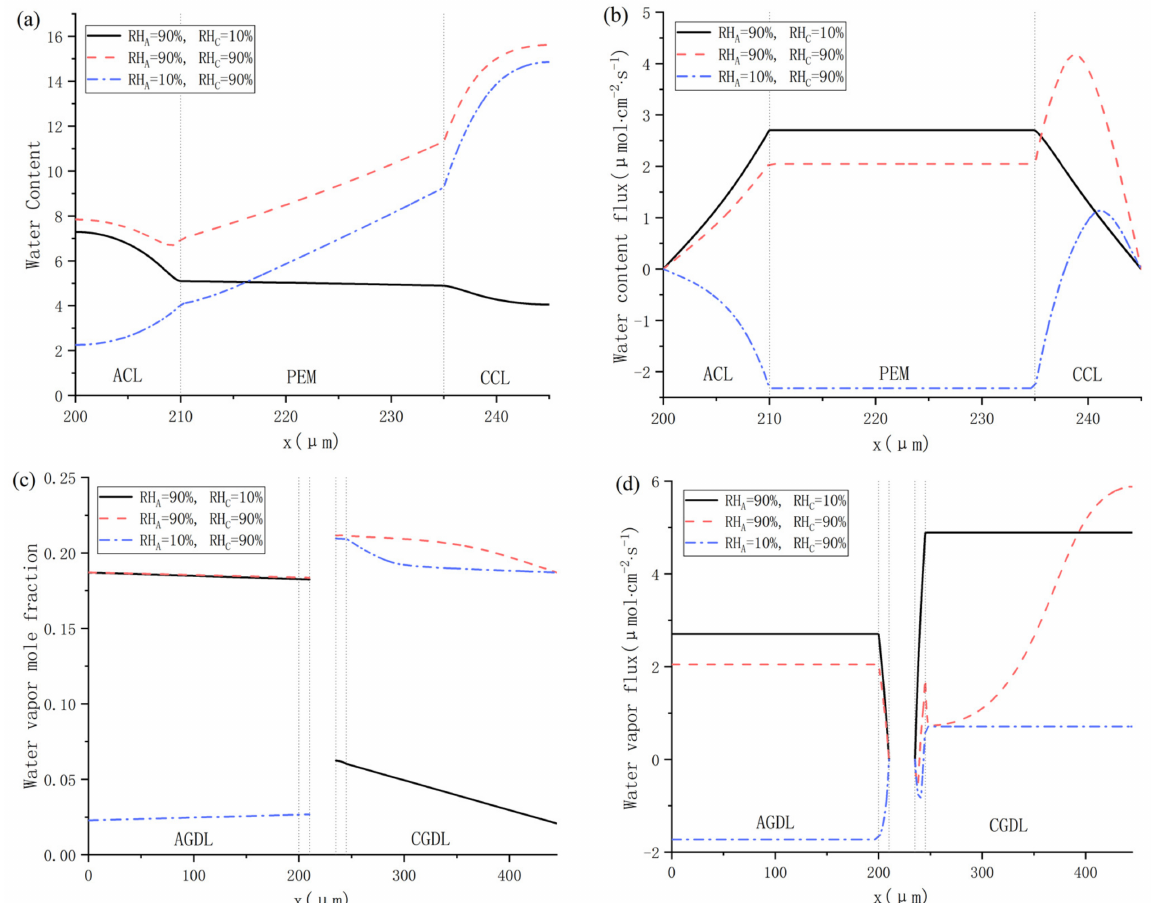
Figure 9. Water distributions under various inlet relative humidity: ( a ) water content; ( b ) water content flux; ( c ) water vapor mole fraction; and ( d ) water vapor